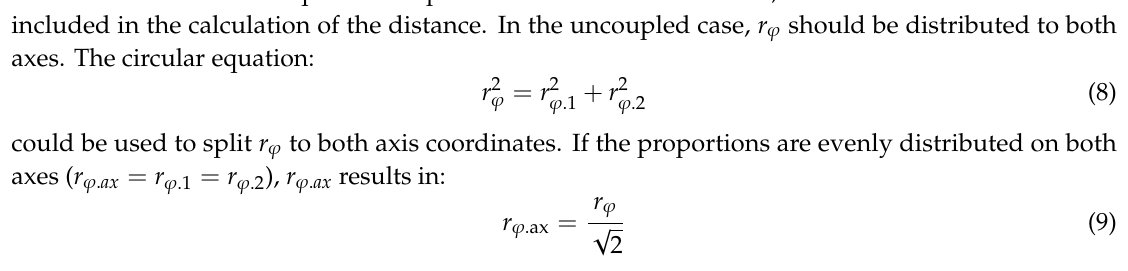
Figure 10. Transmission λ 2 over the workspace of the manipulator.